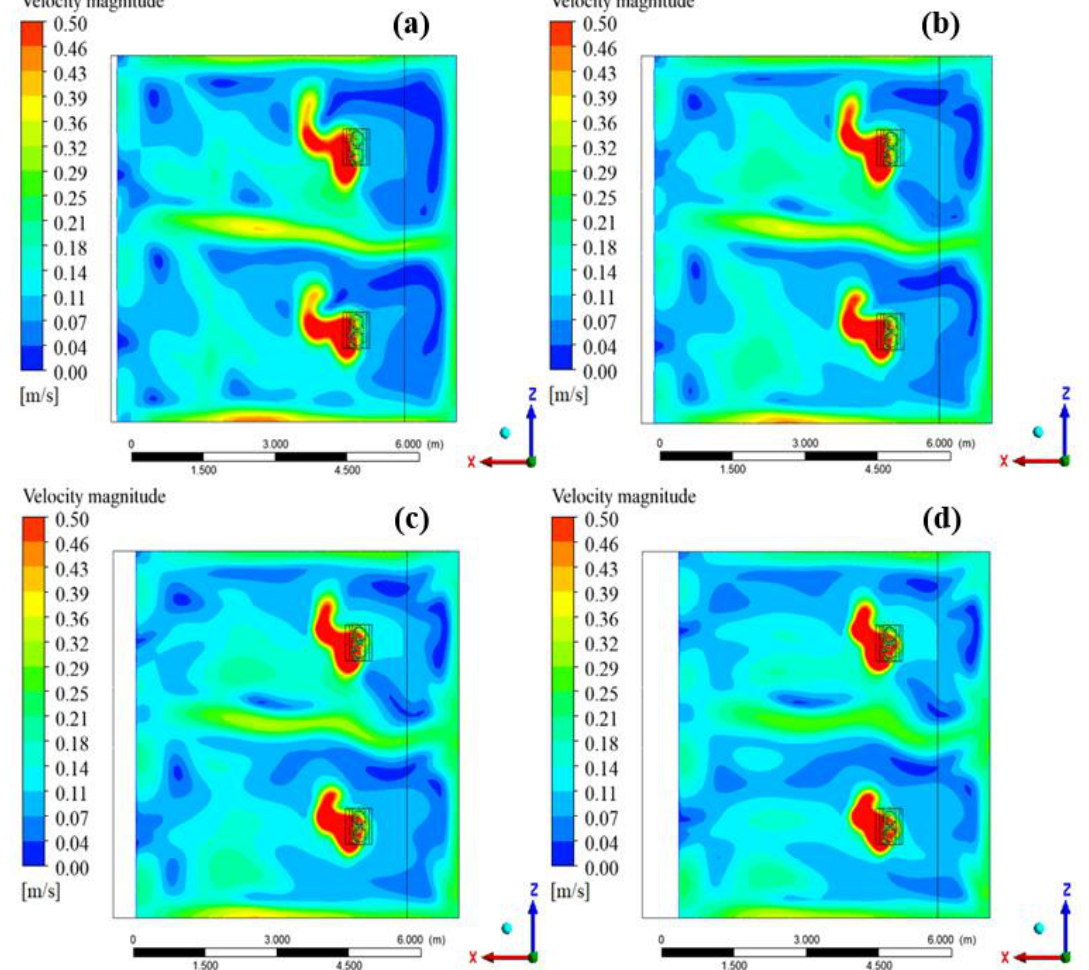
Figure 12. Velocity distribution contours for four horizontal profiles when the fan tilt angle was − 70°: plane 1 — 0.7 m ( a ), plane 2 — 1.0 m ( b ), plane 3 — 1.3 m ( c ), and plane 4 — 1.6 m ( d ).